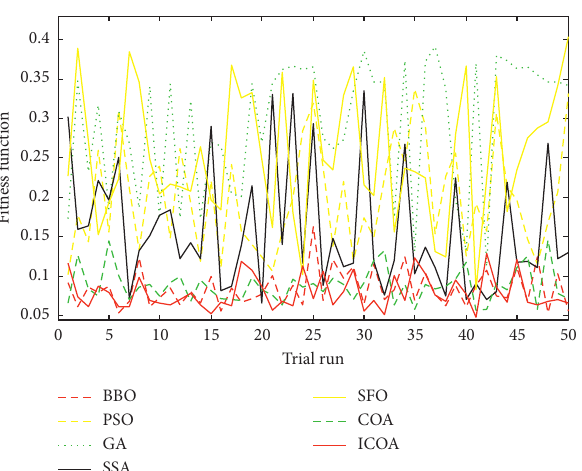
Figure 13: The fitness values of seven methods in 50 trial times for the fourth case.